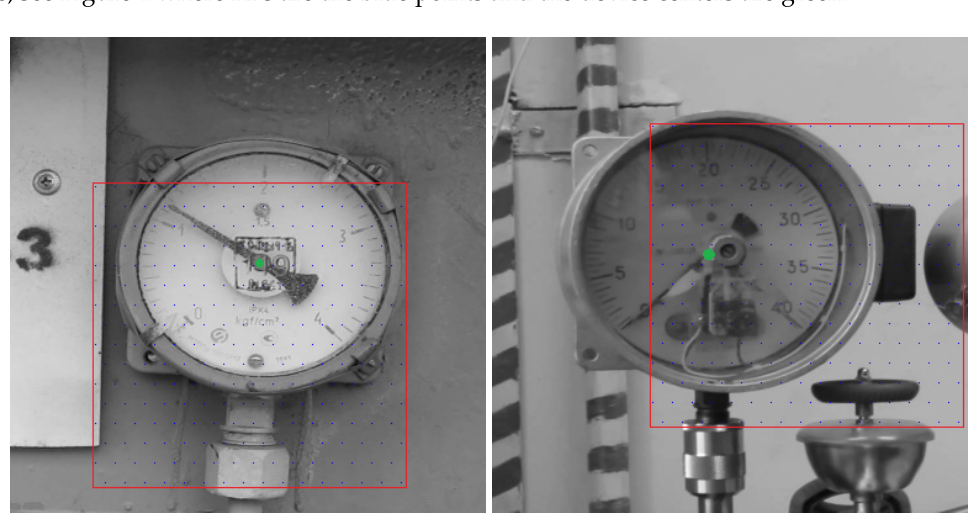
Figure 4. Reference points (blue) for the class N (not shown in the image), the diameter d of the circle built on top of symbol’s reference points (RP) (not shown in the image) and the center { x 0 , y 0 } of an analog dial gauge (bold green dot).